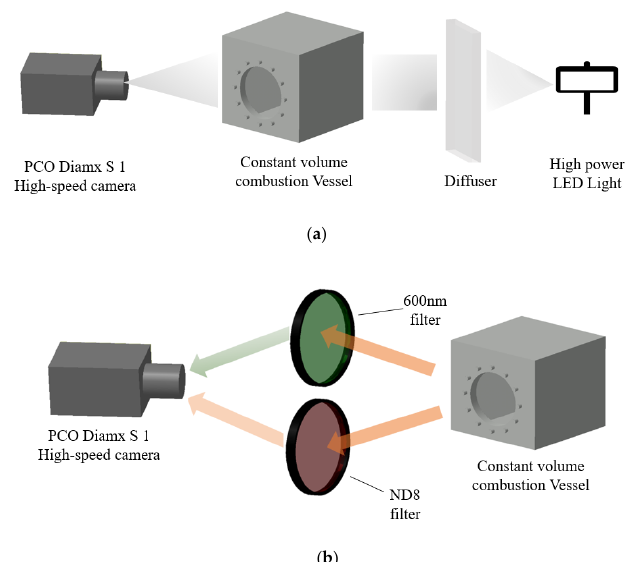
Figure 5. Optical setup of different experiment conditions: ( a ) Spray imaging system with LED and diffuser. ( b ) Ignition and flame with different filter: 600 nm filter for the ignition imaging and ND8 filter for the flame imaging.